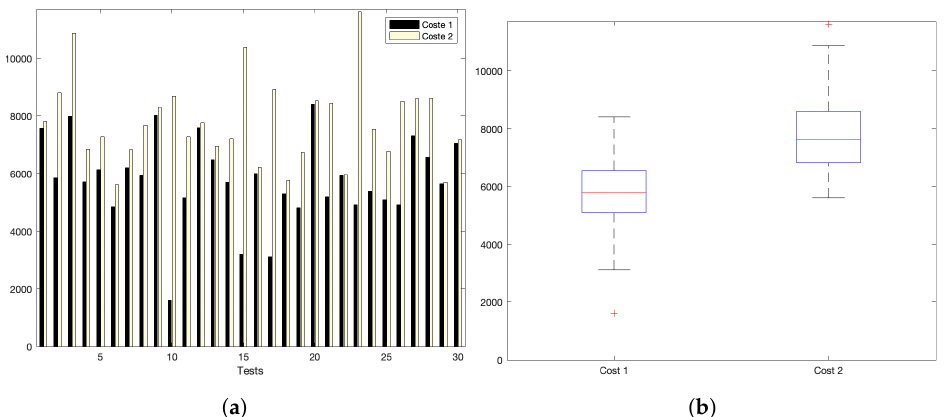
Figure 13. High request-burst rate. ( a ) Individual test values for cost 1 and cost 2 . ( b ) Summary values. Table 8. Dispersion measures of latencies for all scenarios (in ms).